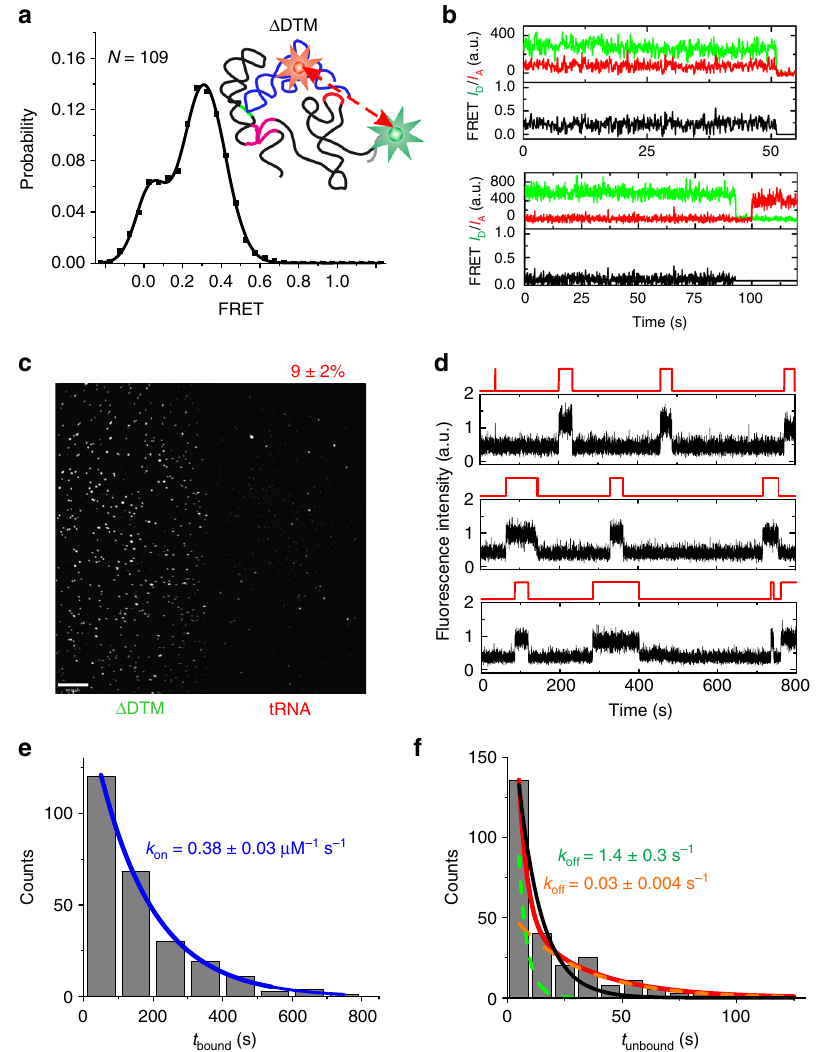
Fig. 5 smFRET and kinetic analysis of tRNA binding to Δ DTM construct. a FRET histogram and b exemplary traces for smFRET measurement between tRNA and the base of antiterminator in the Δ DTM construct at 50 mM Mg 2 + . c Average image of fi rst 30 frames (3 s) for uncharged tRNA binding to the Δ DTM construct at 10 mM Mg 2 + . The few spots in the Cy5 channel represent tRNA molecules that remained associated with the Δ DTM T-box construct ~3 min after immobilization to the slide. d Representative traces for tRNA binding to the Δ DTM construct at 10 mM Mg 2 + . e Dwell-time distribution of t unbound fi t with single-exponential function (blue) to estimate k on . f Dwell-time distribution of t bound fi t with a double-exponential function (red), deconvolved into the fi ts for the fast (green) and slow (orange) components. An alternative fi t with a single-exponential function is shown in black. Errors are s.d. of at least two independent